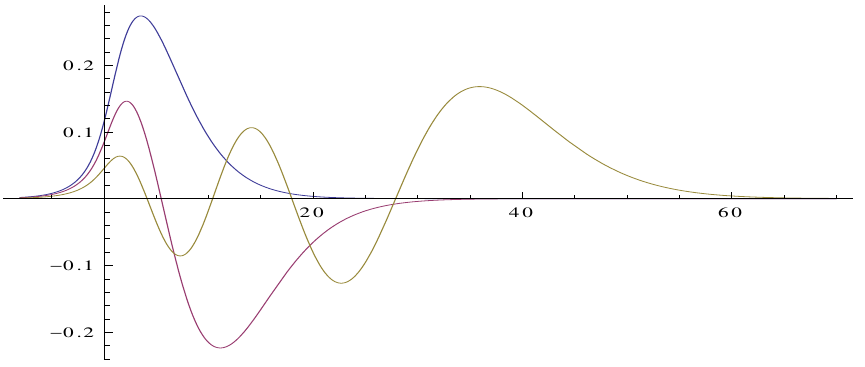
Table 2 . Numerical results for the eigenvalues, slopes and radii with running coupling constant and Higgs-mass regulator.